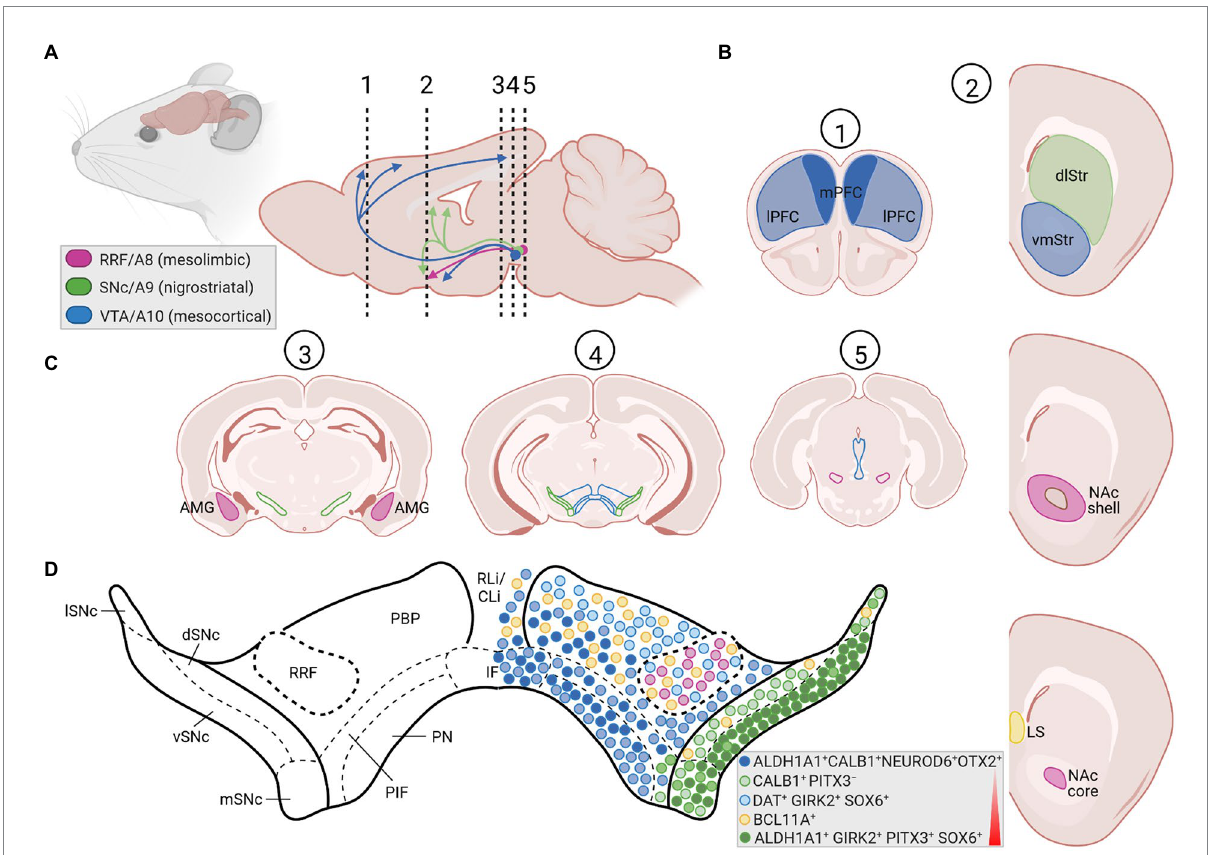
FIGURE 2 The rodent mDA system in the adult brain. (A) Sagittal view (left) and enlarged midsagittal section (right) of the adult rodent (mouse, rat) brain, showing the location of the cell bodies (circles) from the A8 (RRF, pink), A9 (SNc, green), and A10 (VTA, blue) mDA clusters in the VM, and their projections (arrows) to the limbic areas (mesolimbic pathway), striatum (nigrostriatal pathway) and PFC (mesocortical pathway). Note that both the VTA and RRF DA neurons project to limbic areas in the mesolimbic pathway. The dotted and numbered lines indicate the position of the cross sections shown in (B,C) . (B) Cross-sections of the rodent forebrain at the level of the dotted lines #1 and 2 in (A) , depicting the location of the medial (mPFC, dark blue area) and lateral (lPFC, light blue area) PFC (#1) as one target area of the VTA DA subset, of the dorsolateral striatum (dlStr, green area), ventromedial striatum (vmStr, blue area), NAc shell or NAc core (pink area; right panel #2) as preferential target areas of the SNc, VTA and RRF DA subsets, respectively, and of the lateral septum (LS, yellow area) innervated by NEUROD6-and BCL11A-expressing mDA neurons. (C) Cross-sections at different rostro-caudal levels of the rodent midbrain, indicated by the dotted lines #3, 4 and 5 in (A) , indicating the positions of the SNc (green lines), VTA (blue lines) and RRF (pink lines) DA subpopulations, as well as the location of the amygdala (AMG, pink area) as another target area in the mesolimbic pathway. Labeling of other brain regions in these sagittal and coronal views have been omitted for clarity. (D) Enlargement of the mDA region in the medial rodent VM [level of the dotted line and cross-section #4 in (A,C) , respectively], showing the SNc (ventral tier, vSNc; dorsal tier, dSNc; medial tier, mSNc; and lateral tier, lSNc), VTA (PBP, parabrachial pigmented nucleus; PN, paranigral nucleus; IF, interfascicular nucleus; PIF, parainterfascicular nucleus; RLi, rostral linear nucleus; CLi, caudal linear nucleus of the raphe), and RRF subdivisions. Colored circles depict the approximate positions and proportions of mDA neurons with distinctive gene expression signatures (legend in bottom right corner) within these subdivisions, as summarized in this article. Colors and shadings indicate the increasing vulnerability (red triangle) of these mDA subsets to neurodegeneration. Intermediate shadings denote mDA subsets not defined here. Created with